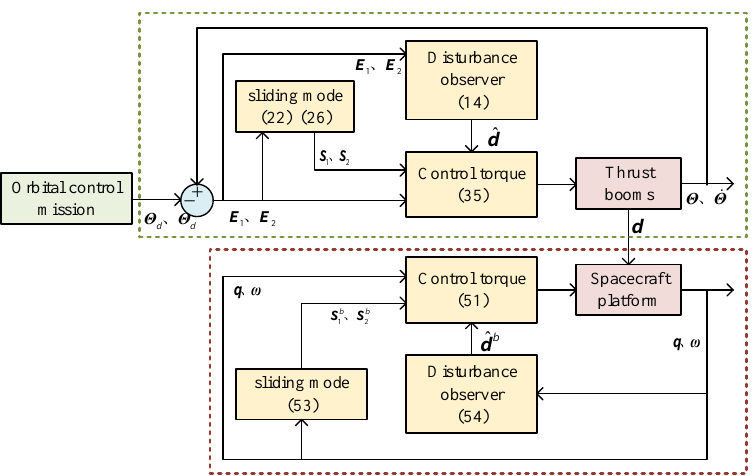
Figure 3. Control system structure.